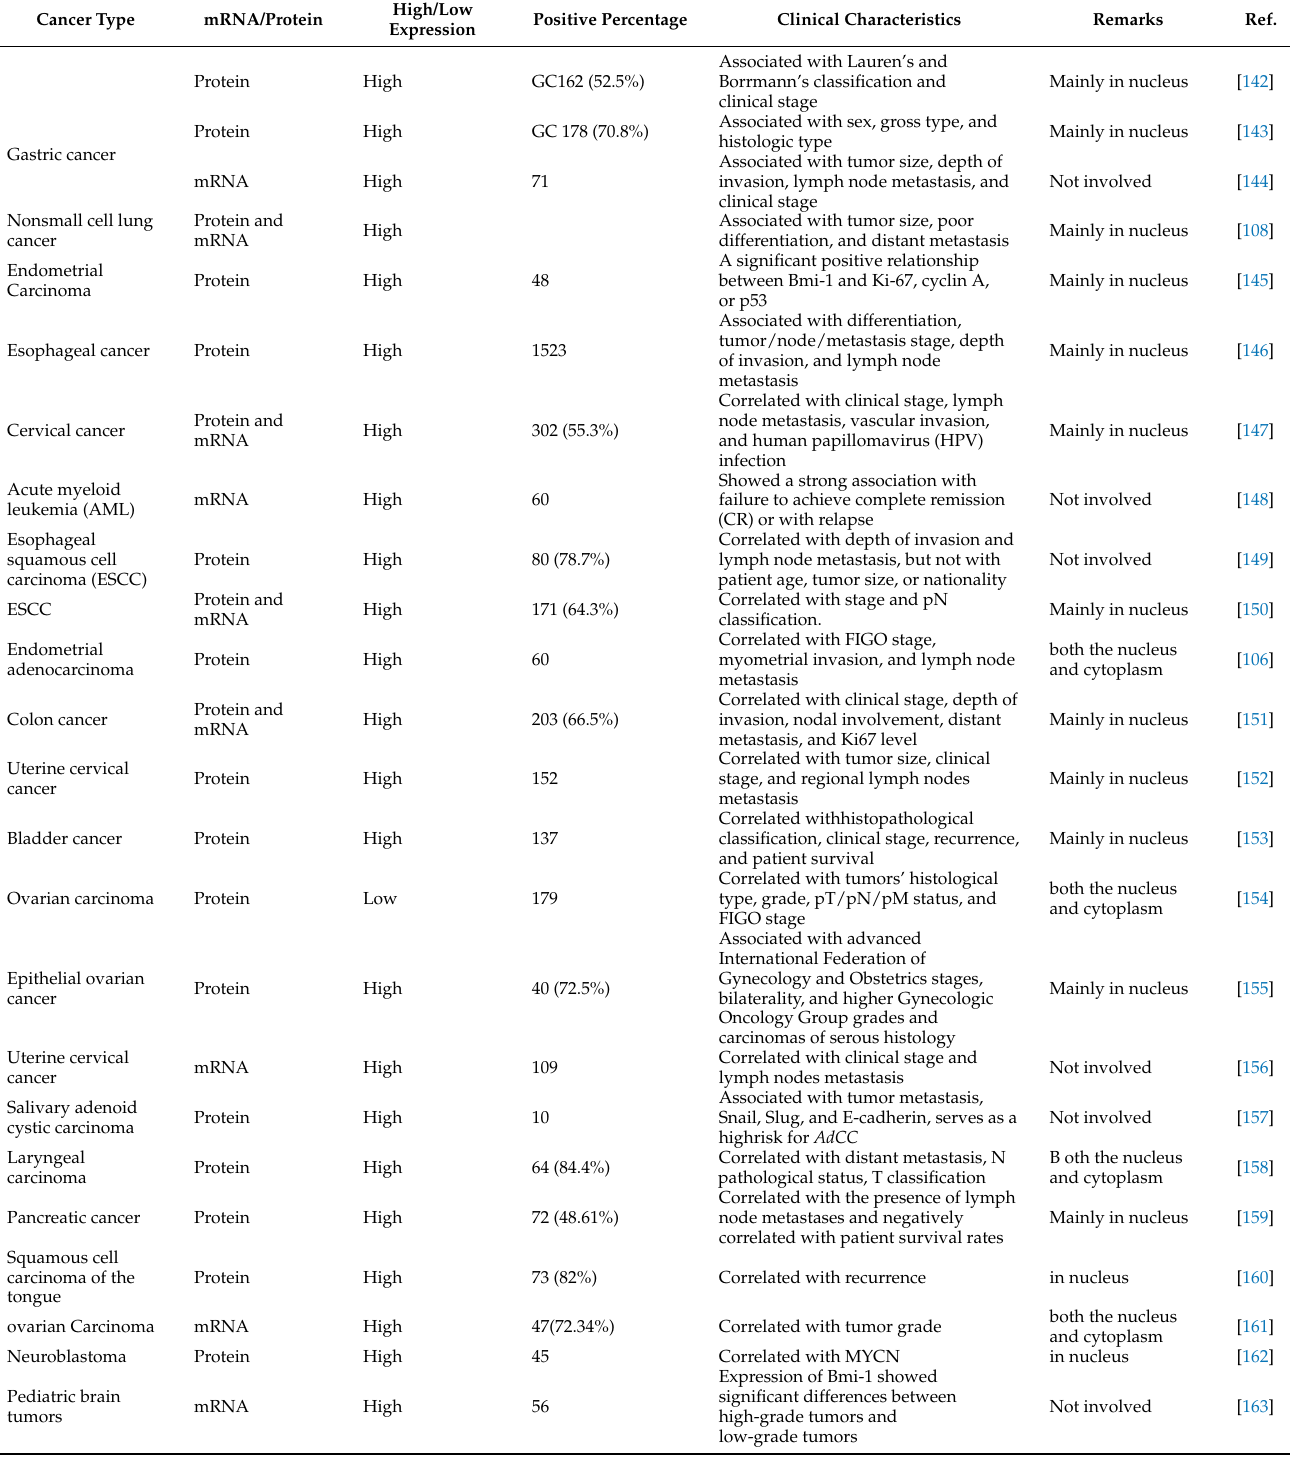
Table 2. Protein expression and clinical characteristics of